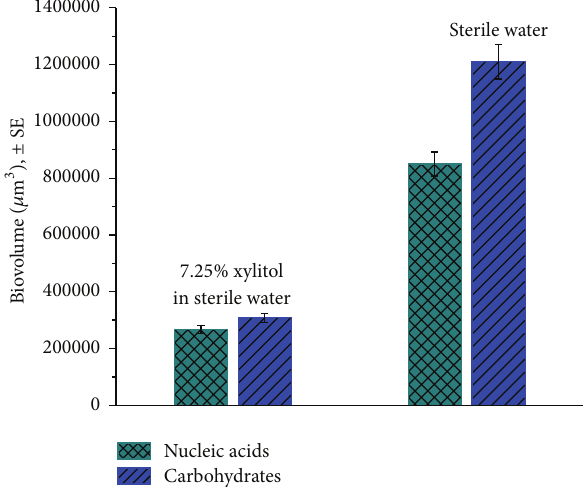
Figure 6: Biovolume of S. mutans UA159 biofilm components following a single 60-second exposure of treatment with 7.25% xylitol solution or sterile